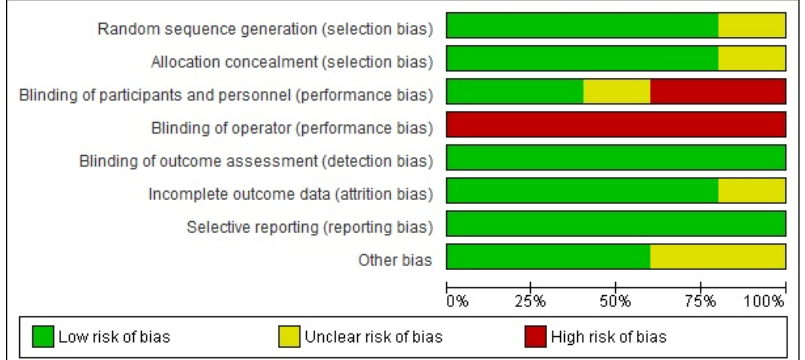
Figure 3. Individual RCT risk of bias across studies.